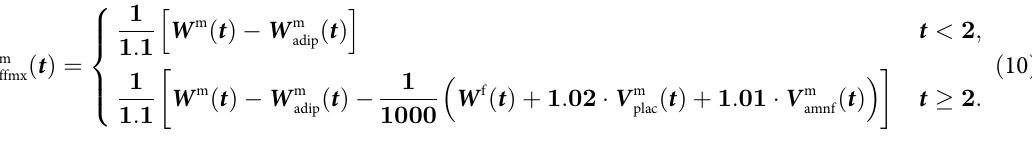
Here, we have assumed that the products of conception appear at gestational age 2 weeks, and that the densities of the placenta and amniotic fluid are 1.02 g/mL [53] and 1.01 g/mL [54], respectively (cf. Table 8). (We further assumed that W m , W f , W m described by Eqs 1, 2, 3, 8 and 9, respectively.) Also, the total volume (L) of all the specific maternal compartments, excluding adipose tissue, is (We assumed that the quantities on the right-hand side of this equation are described by Eqs 5 and 7 and the values listed in Table 13.) Thus, the volume of the maternal rest of body